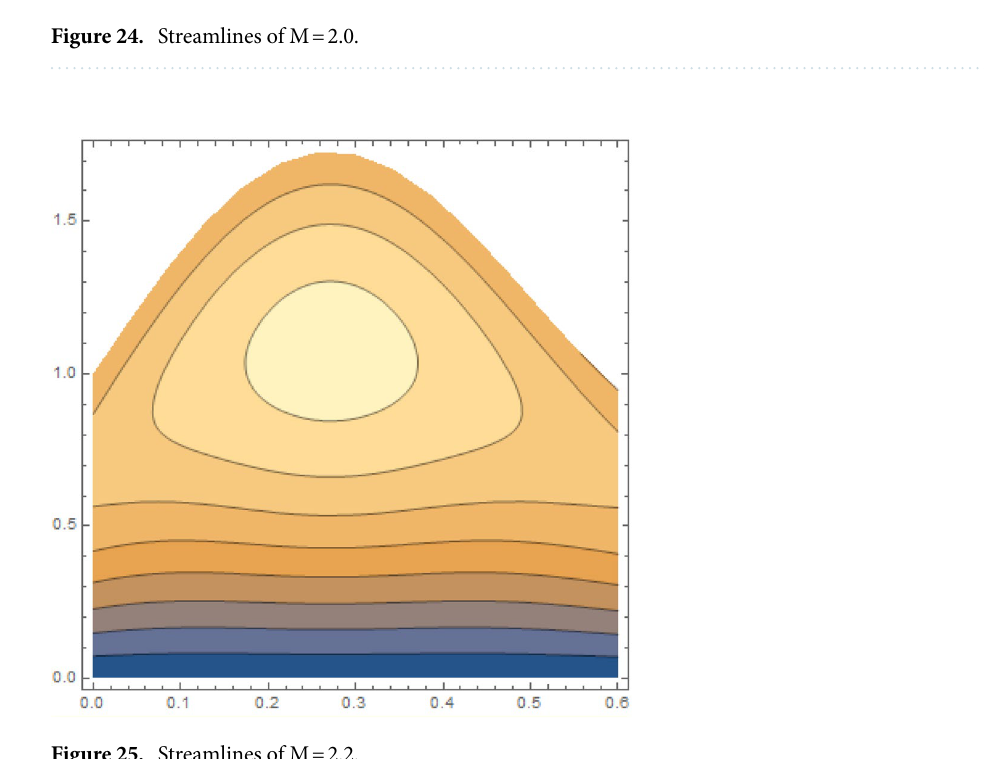
Figure 25. Streamlines of M =